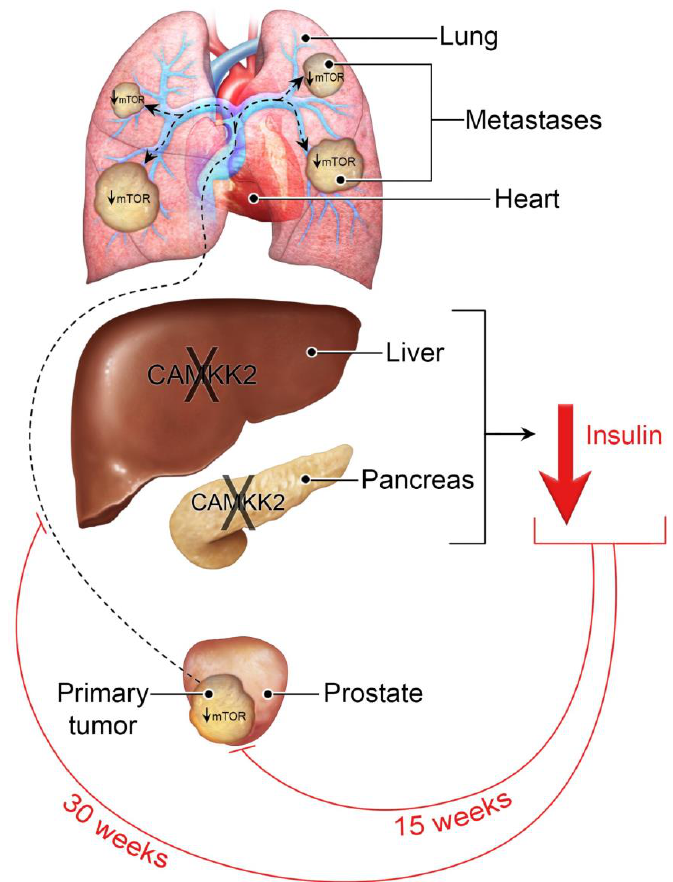
Figure 7. Working model for CAMKK2’s proposed tumor-extrinsic role in prostate cancer. We propose that Camkk2 KO in the liver and/or pancreas protects against metabolic syndrome. One consequence of this is lowered circulating insulin (or some insulin-like molecule), which slows early primary tumor growth and later metastatic colonization through decreasing cancer cell-intrinsic, oncogenic mTOR